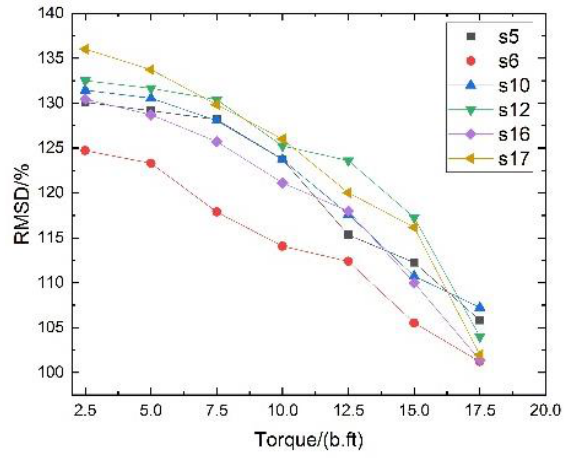
Figure 14. The relationship between normalized peak values and torque levels on six bars.